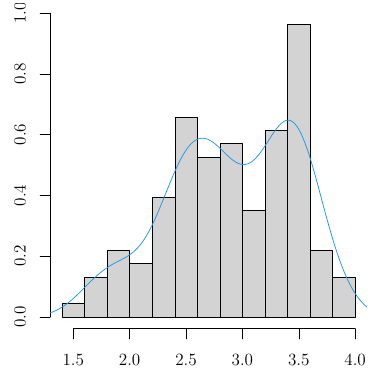
Figure 5 – Histogram and the non-parametric density estimation (blue line) of the time series of the Canadian lynx, from 1821 to